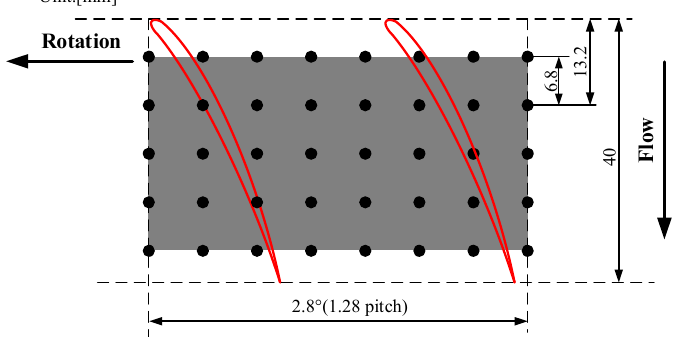
Figure 13. Relative position of the sensing points and the rotor blade.